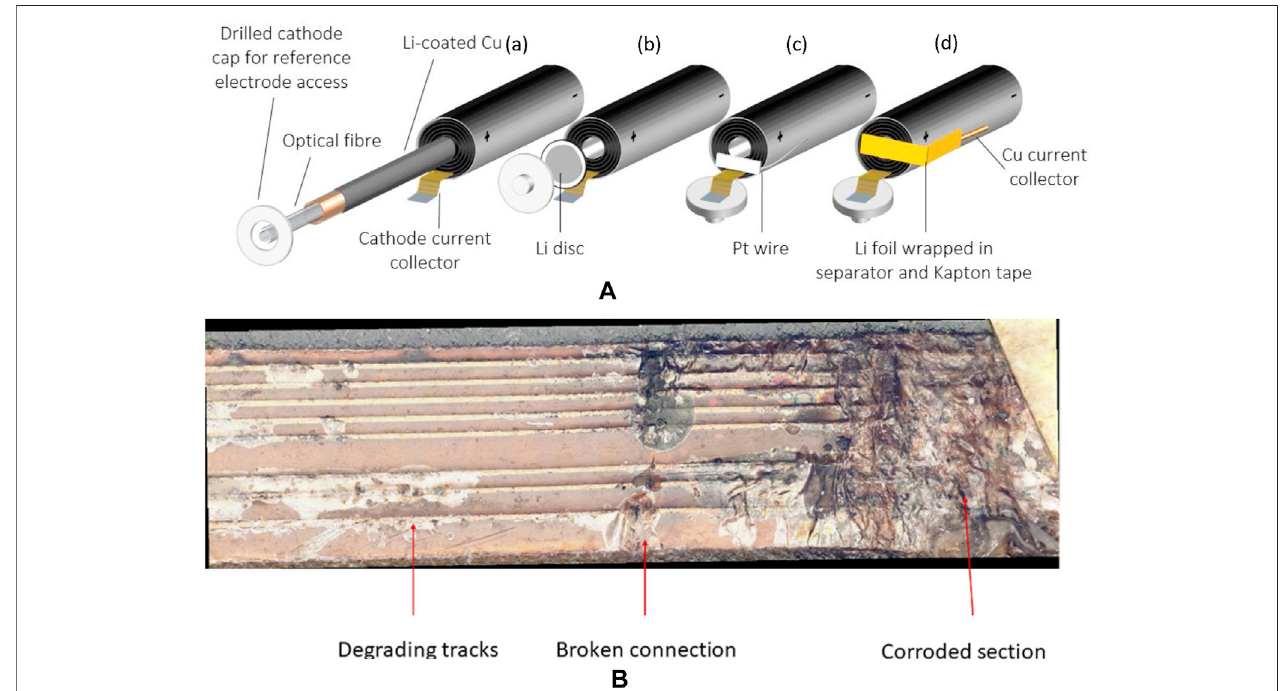
FIGURE 5 | Common challenges of hard sensors. (A) Sealing con fi gurations of a cylindrical cell with an embedded thermo-electrochemical sensor (McTurk et al., 2018; Panel 2, p. 311). (B) A microscopic image of a damaged thermistor due to the harsh environment of the cell (Fleming et al., 2019; Panel 9; Appendix A). (CC BY- NC-ND 4.0).